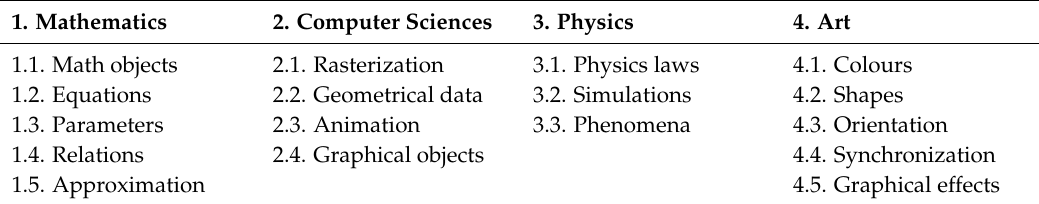
Table 1. Computer graphics